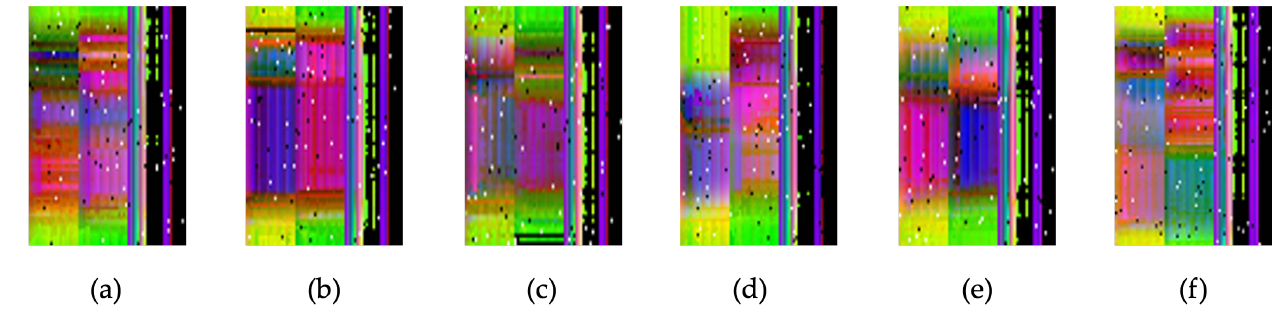
Figure 9. Image with salt-and-pepper noise applied to the word; ( a ) highway; ( b ) heart attack; ( c ) fever; ( d ) bleeding; ( e ) bomb; ( f ) fire.